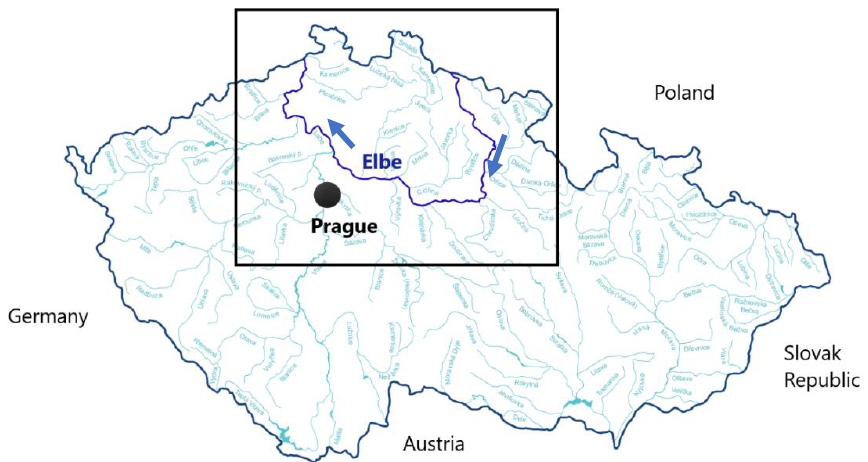
Figure 1. Map of the Elbe River basin in the Czech Republic. Blue arrows show the direction of the River Elbe flow.